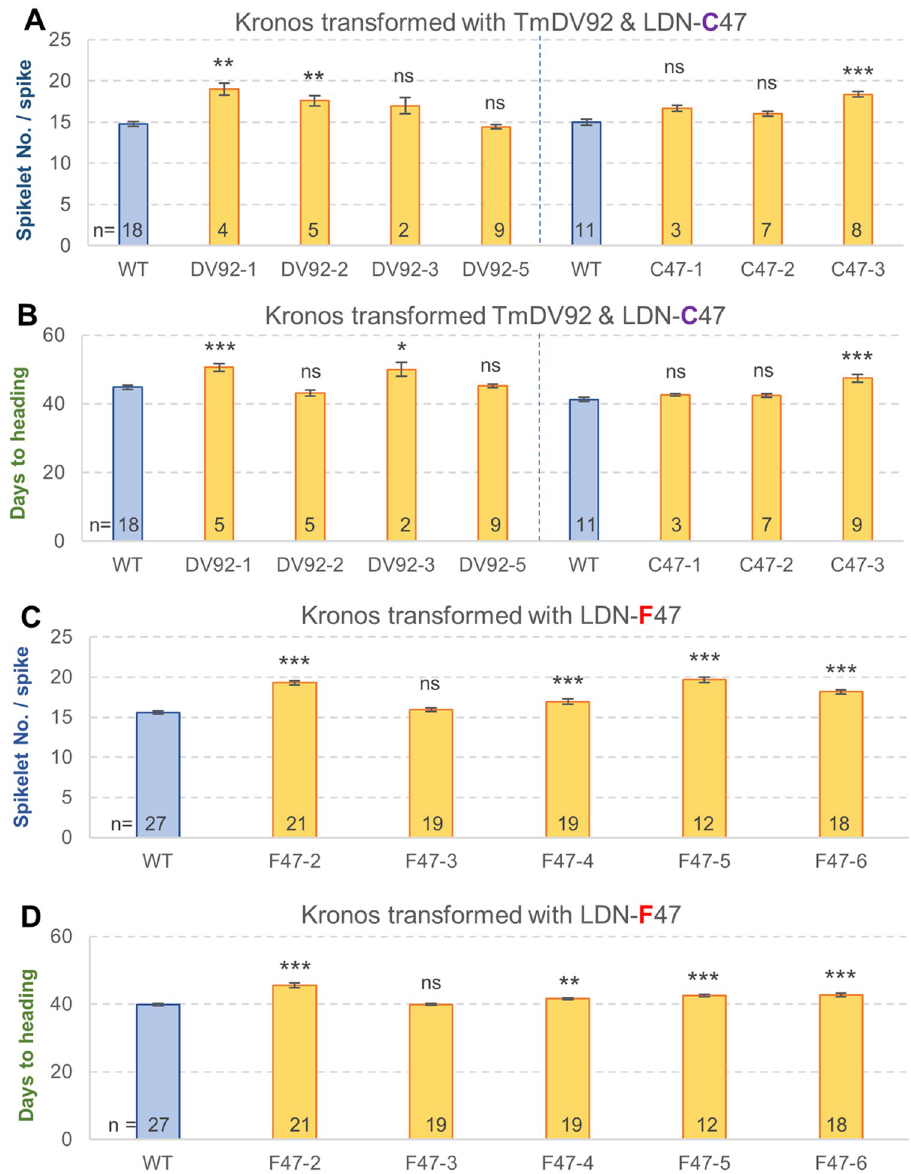
Fig 2. Effect of transgenic WAPO-A1 alleles on spikelet number per spike and heading date. ( A-B ) Greenhouse experiment comparing four independent TmDV92 transgenic lines and three independent lines carrying the LDN-C47 allele with their respective non-transgenic sister lines (pooled from different events). ( C-D ) Separate greenhouse experiment comparing five independent transgenic lines carrying the LDN-F47 allele with the pool of non- transgenic sister lines. ( A and C ) Spikelet number per spike (only the spike from the main tiller was measured in each plant). ( B and D ) Heading date. Bars are averages and error bars are s.e.m. Numbers inside bars indicate number of plants and asterisks indicate P values (Dunnett test) relative to the pool of non-transgenic sister lines carrying the same construct. ns = not significant, � = P < 0.05, �� = P < 0.01 and ��� = P < 0.001. Data used for this figure and the corresponding statistical analyses are available in Data B in S1